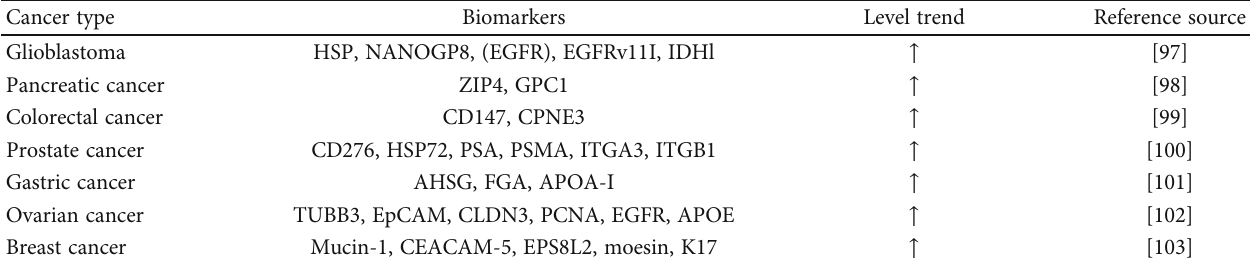
Table 2: CSC-Exo-derived proteins acting as biomarkers in